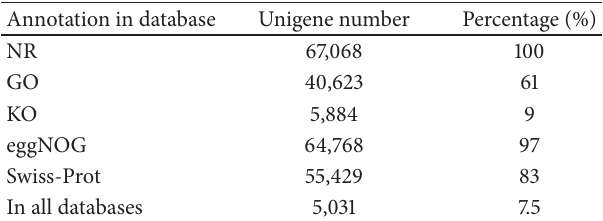
Table 2: Overview of